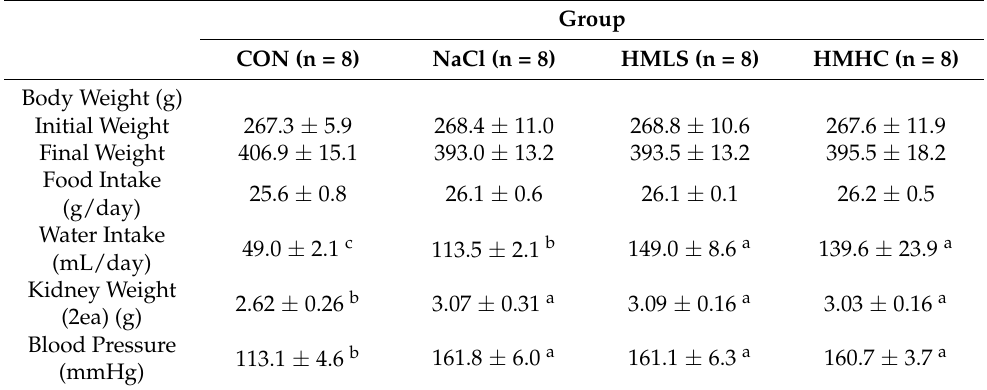
Table 1. Body Weight, Food Intake, Water Intake, Kidney Weight and Blood Pressure Values of